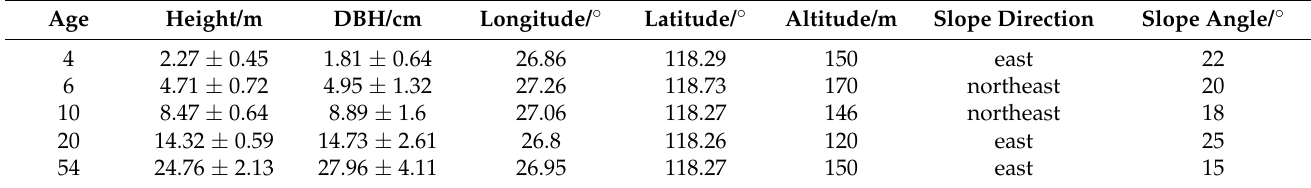
Table 1. Basic information of differently aged samples of S. superba .